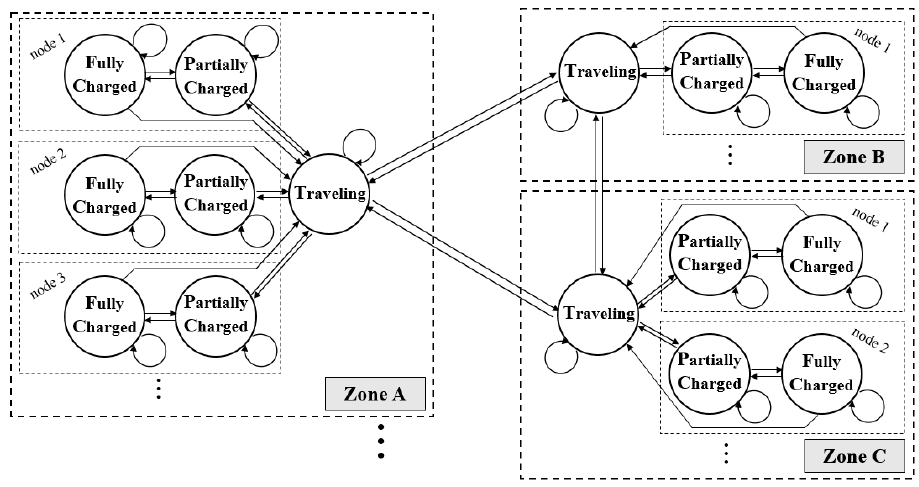
Figure 1. Markov chain for electric vehicle (EV) state estimation.